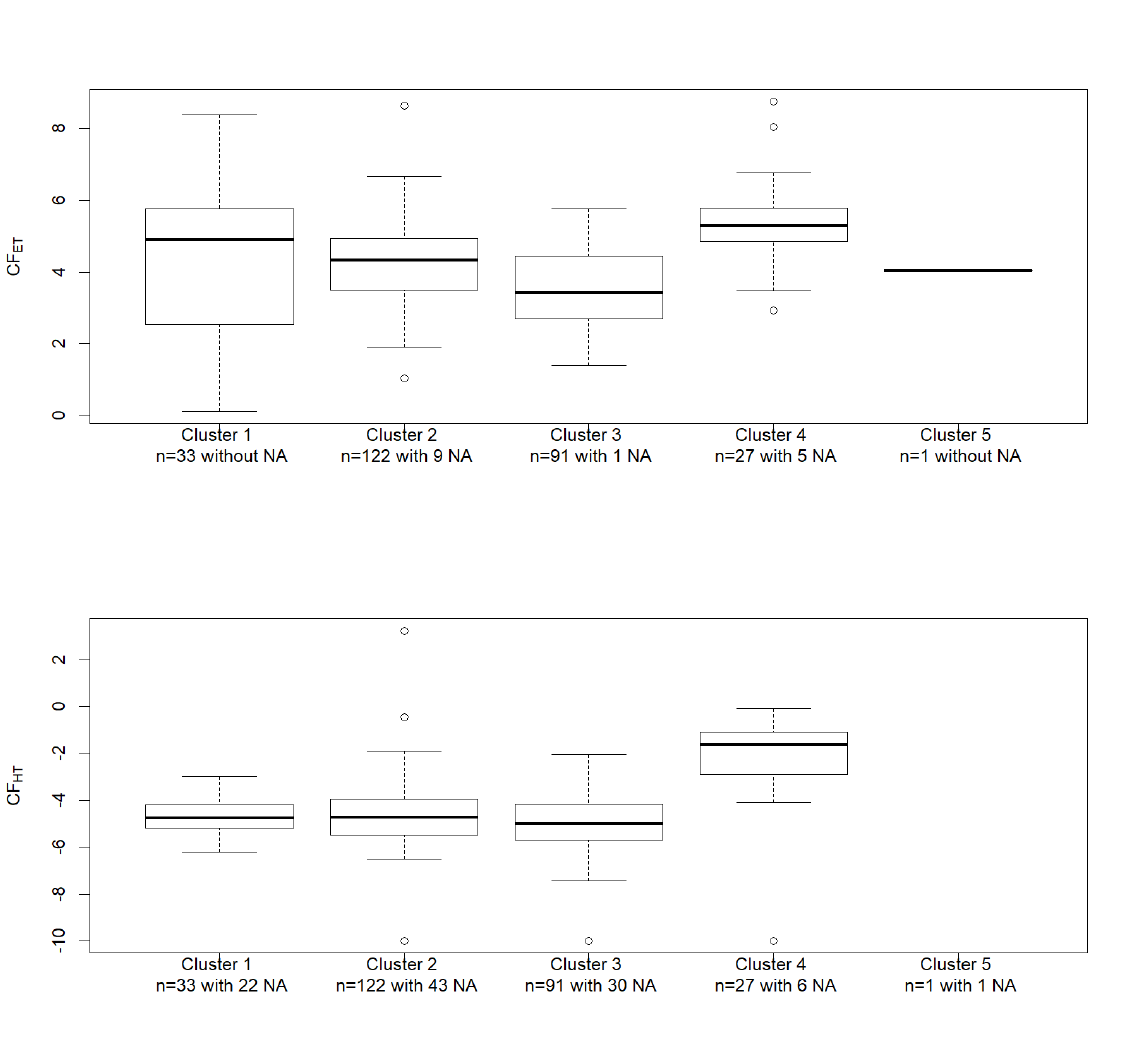
Figure 3 - Boxplot by cluster for the CF ET and CF HT values. Note that the unique compound of Cluster 5 has no CF HT value. The size of the clusters and the numbers of NA are gathered in the legend. The predictions will be made difficult for the CF ET of cluster 1 as it covers a wide range whereas it includes a relatively small number of compounds. On the contrary, cluster 3 covers a small range with no extreme values and includes a high number of compounds, for this cluster the cluster-then-predict approach could produce interesting